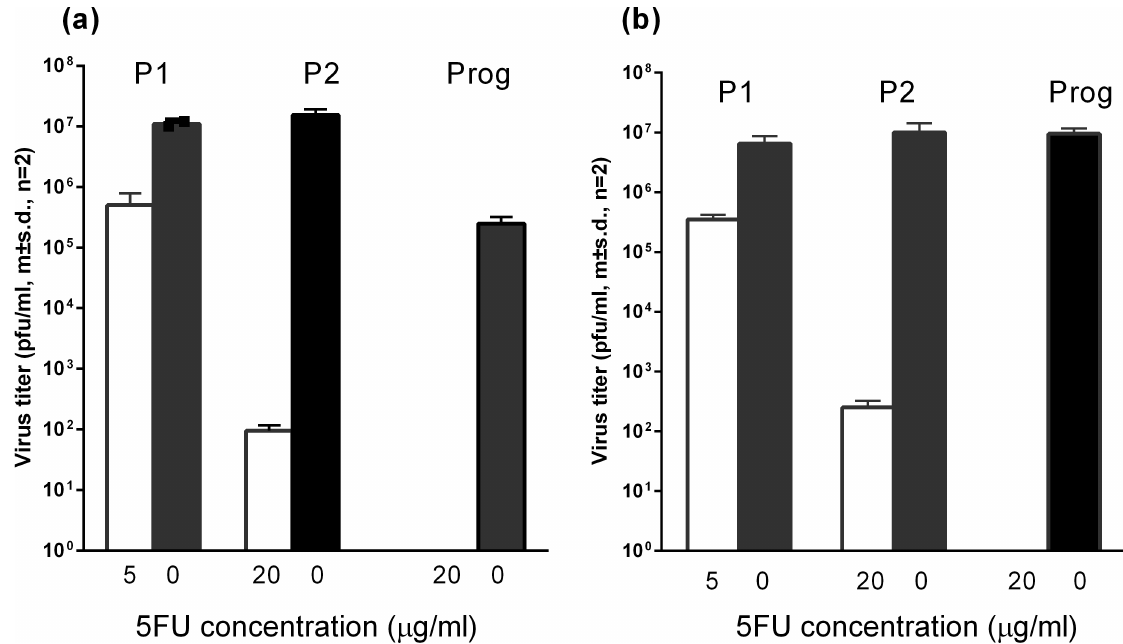
Fig 2. Titres of extracellular virus in cultures of C6-36 cells 7 days after infection with (a) WT DENV1 or (b) DENV1 derived from an infectious clone of the WT virus. Virus (culture medium) from cultures treated with 5 μ g/ml 5FU (P1, open bars) was transferred to cultures of C6-36 cells in the presence (solid bars) or absence (open bars) of 20 μ g/ml 5FU. Virus (culture medium) from cultures treated with 20 μ g/ ml 5FU (P2, open bars) was transferred to cultures of C6-36 cells in the presence (open bars) or absence (solid bars) of 20 μ g/ml 5FU. Prog.– progeny of the pre-extinction stocks of virus.